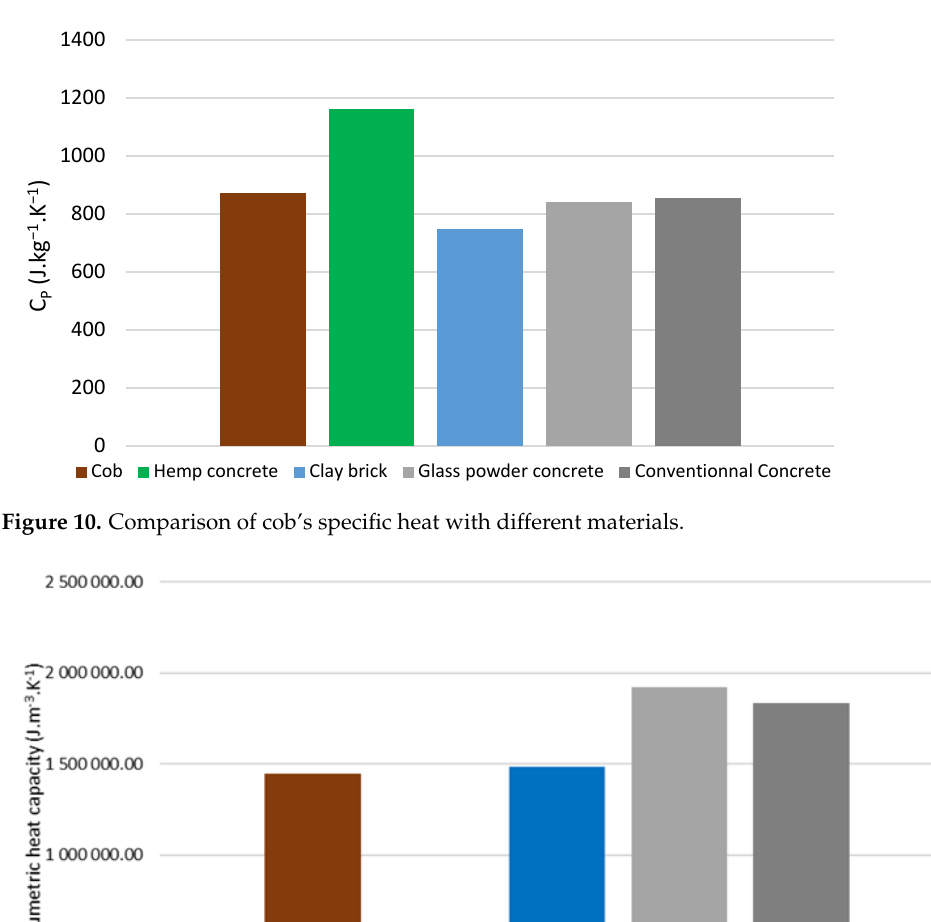
Figure 9. Specific heat capacity of cob in the range temperature exploited and linear fitting.